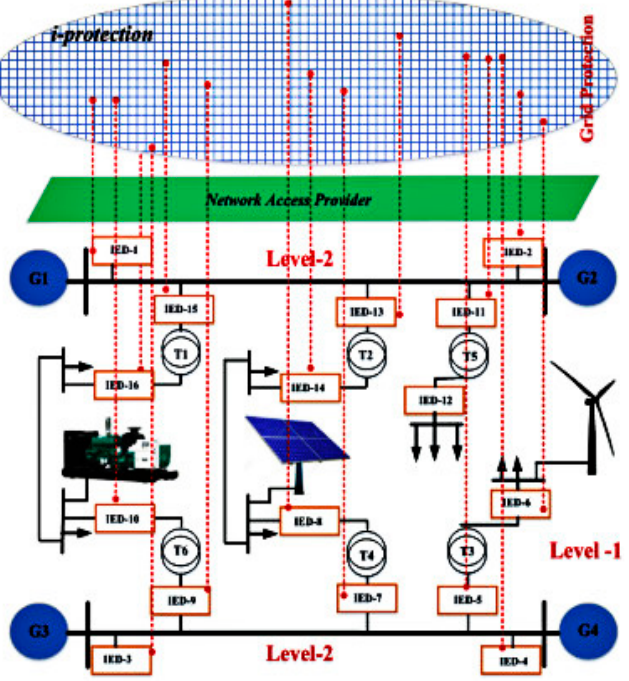
Figure 5. New relay topology based on i -protection [105].